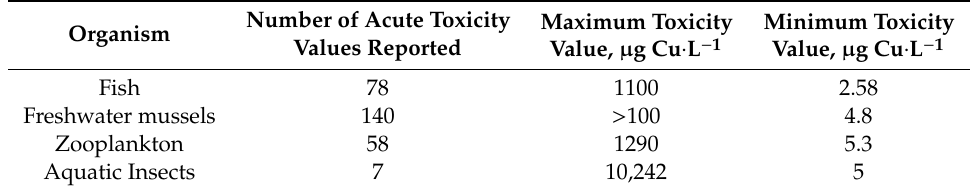
Table 1. Summary of acute toxicity values reported in published literature for di ff erent aquatic species. Source